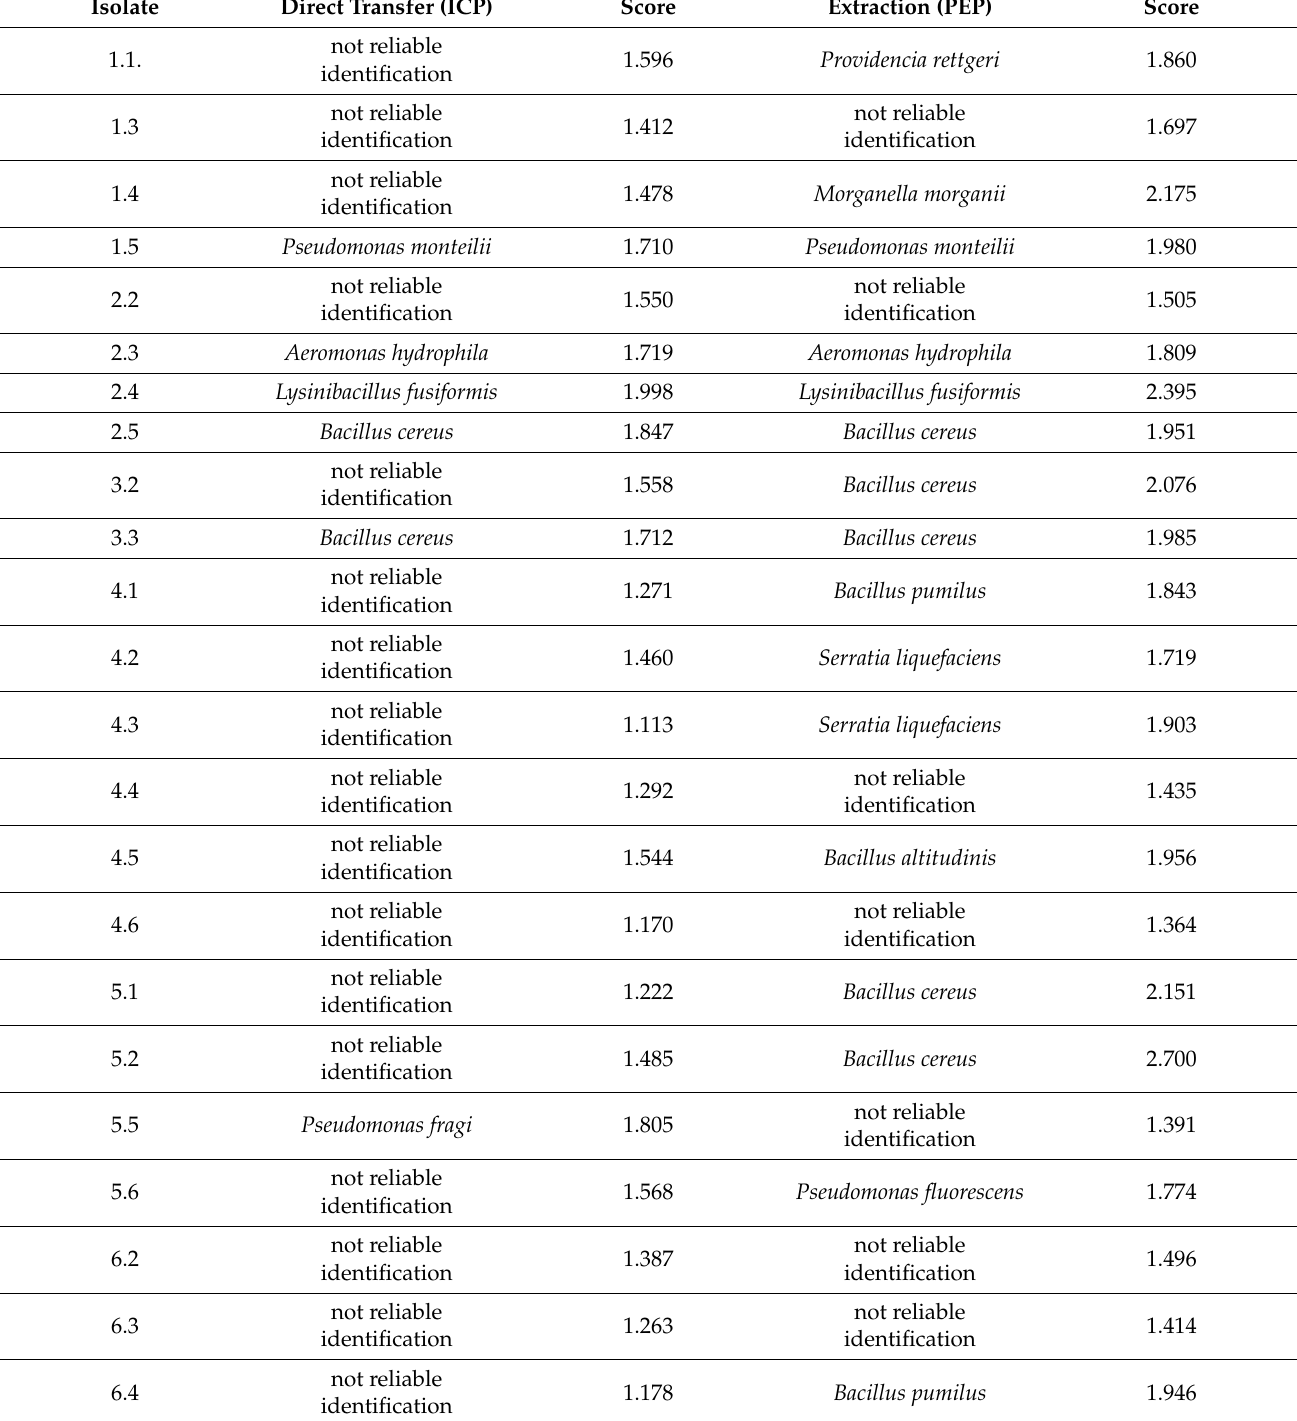
Table 2. Identification results by MALDI TOF mass spectrometry for direct transfer (intact